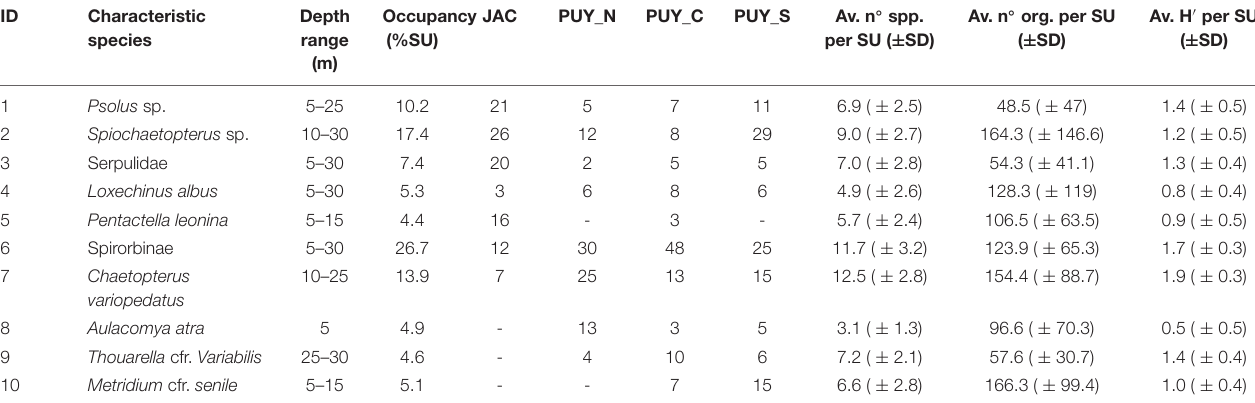
TABLE 3 | Main features of the 10 communities identified in this